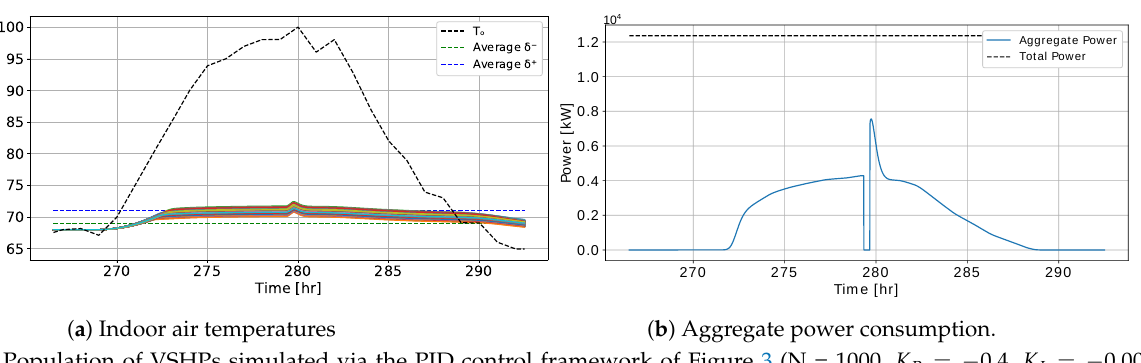
Figure 4. Population of VSHPs simulated via the PID control framework of Figure 3 (N = 1000, K P = − 0.4, K I = − 0.001, and K D = −